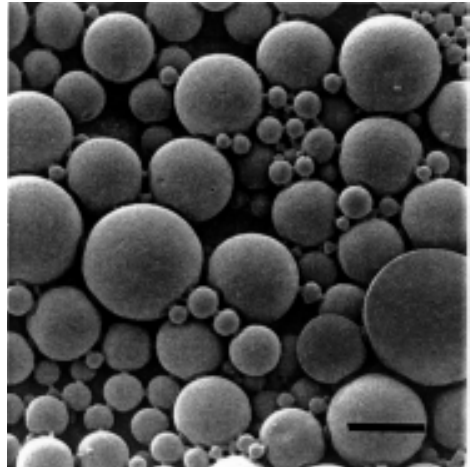
Figure 1 - Scanning electronic photomicrograph of PLGA mi- crospheres obtained by the mul- tiple emulsion W/O/W method. Bar = 5